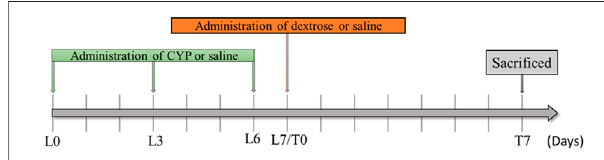
FIGURE 1 | Experimental design of dextrose prolotherapy in IC rat model. (L0 (cid:1) Lesion Day 0; L3 (cid:1) Lesion Day 3; L6 (cid:1) Lesion Day 6; L7/T0 (cid:1) Lesion Day 7/Treatment Day 0; T7 (cid:1) Treatment Day 7; CYP (cid:1)